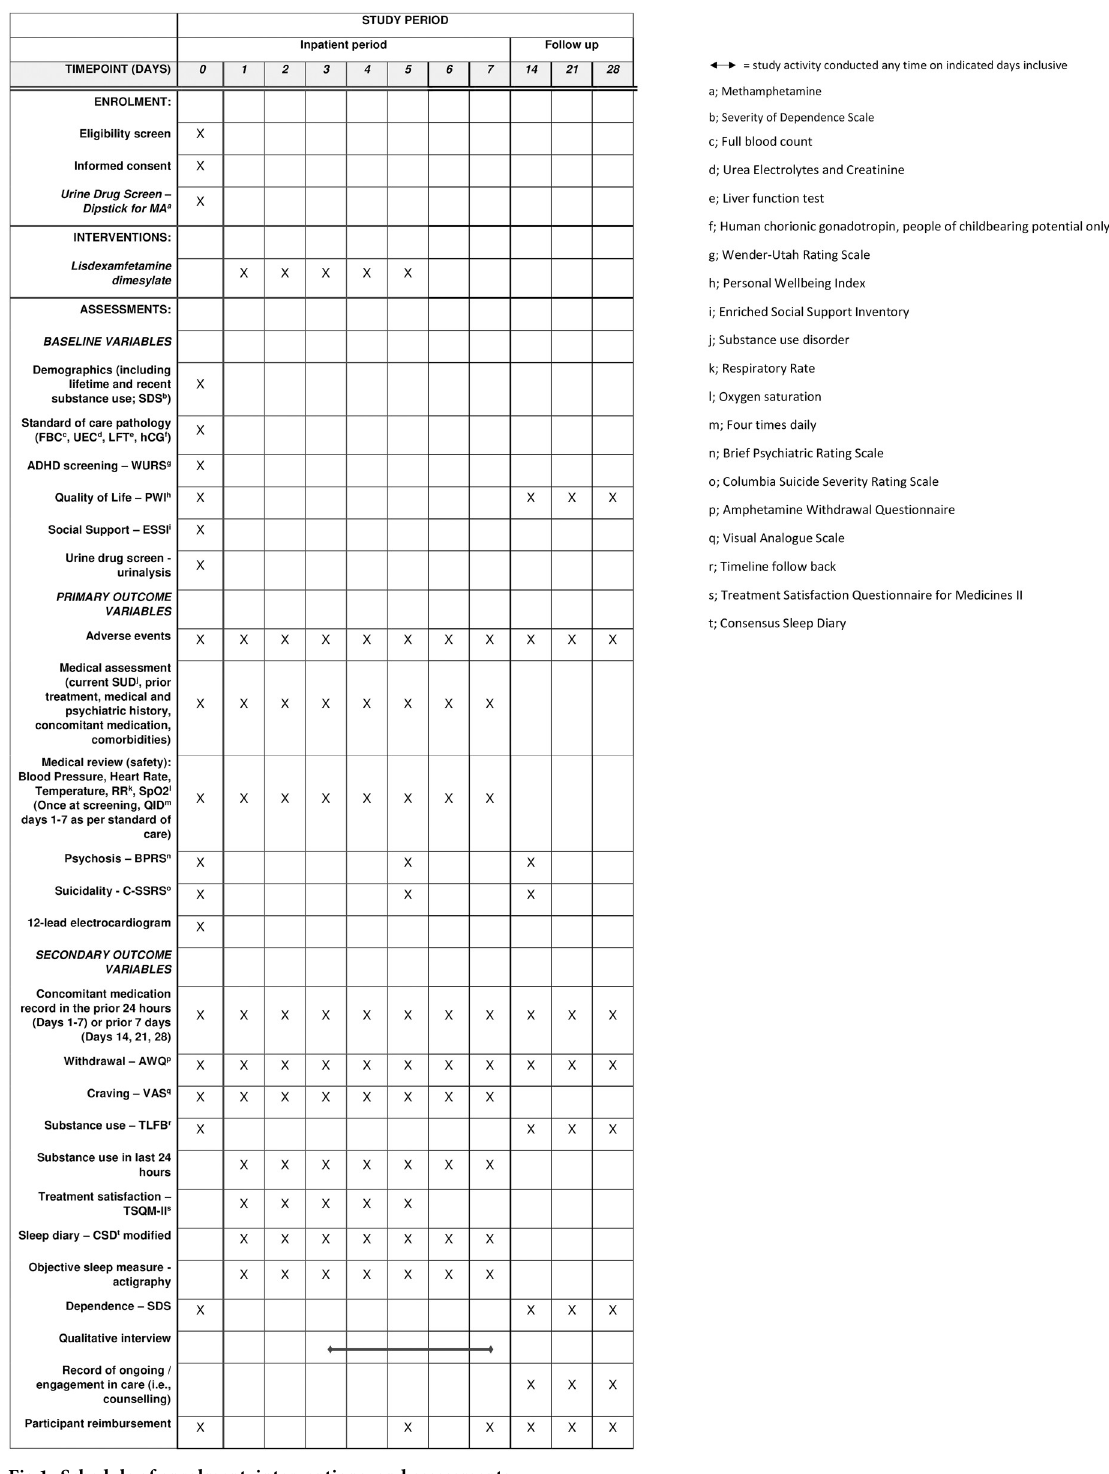
PLOS ONE | https://doi.org/10.1371/journal.pone.0275371 October 3,